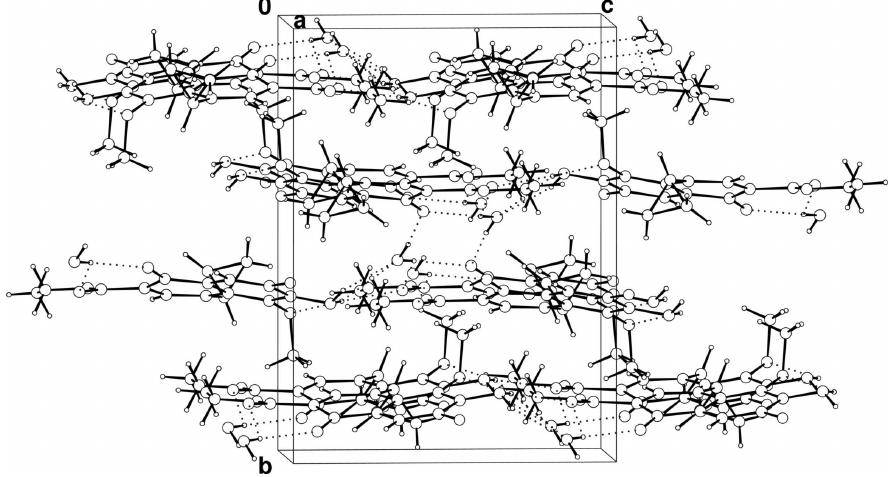
Figure 2 Crystal packing of the title compound, viwed down the a axis. Hydrogen bonds are shown as dashed